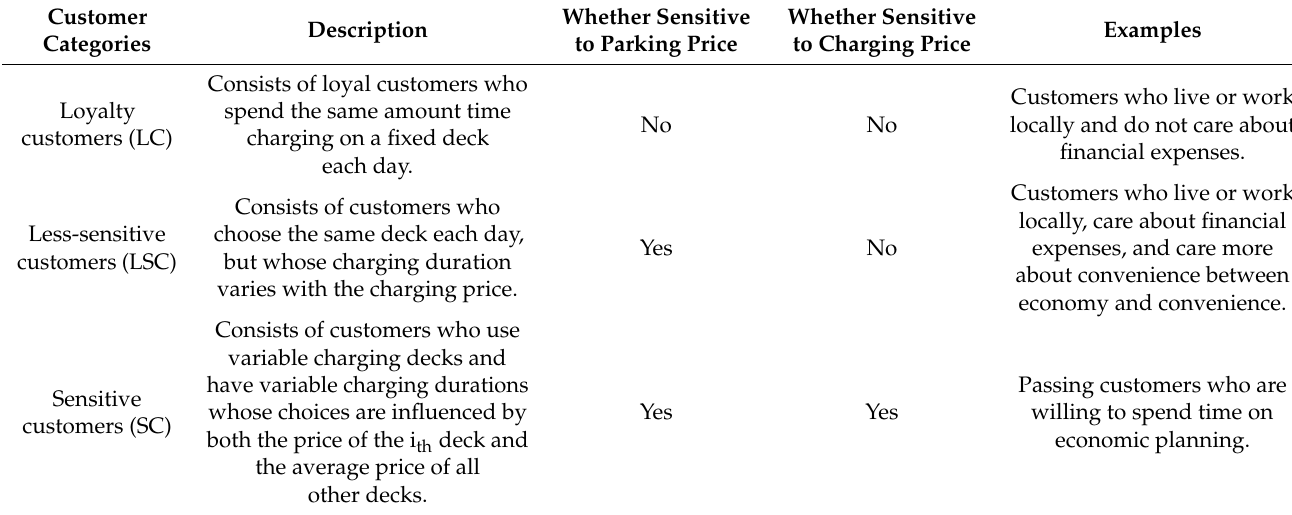
Table 1. Customer groups with different